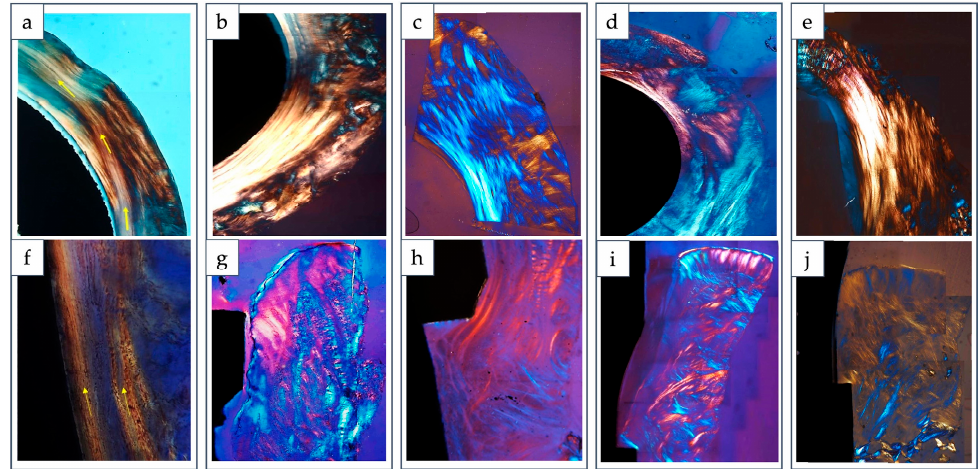
Figure 7. Polarized light microscopy. Transversal sections ( a – e ): ( a ) Ctr1_st_wt showed bundles better organized; ( b ) Ctr2_lt_no-wt, ( c ) Pt1_st_no-wt, ( d ) Pt2_st_no-wt_r, ( e ) Pt2_st_no-wt_l showed a predominance of transversal bundles. Longitudinal sections ( f – j ): ( f ) Ctr1_st_wt and ( h ) Pt1_st_no-wt showed fibers parallel to the long axis of the implant abutment; a network composed by woven bundles was observed in ( g ) Ctr2_lt_no-wt; ( i ) Pt2_st_no-wt_r and ( j ) Pt2_st_no-wt_l ( a , f ) from Ref.